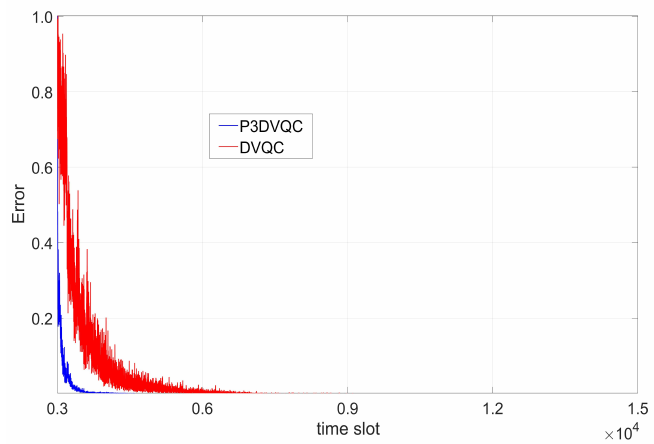
Figure 5. Convergence